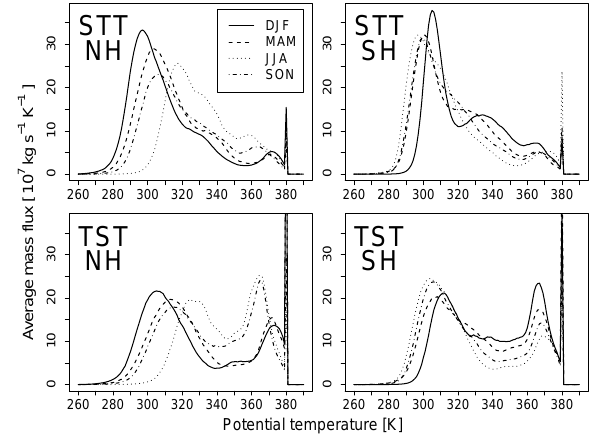
Fig. 10. Potential temperature distribution for STT (top) and TST (bottom) in the NH (left) and SH (right) averaged from 1979 to 2011. The seasons are indicated by different line patterns as listed in the